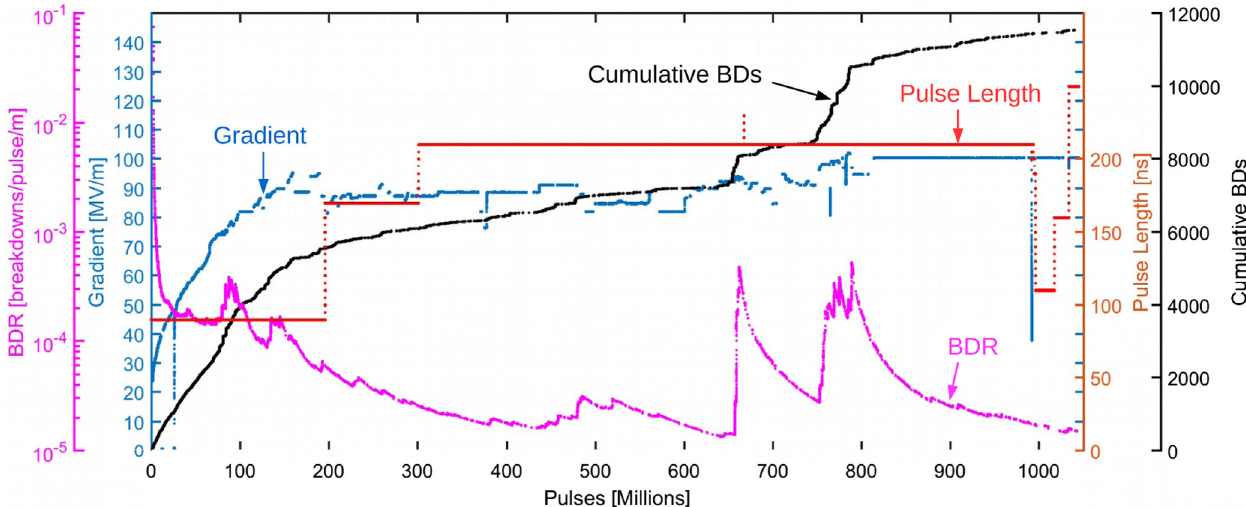
FIG. 12. Summary of the CLIC-G-Open high power test